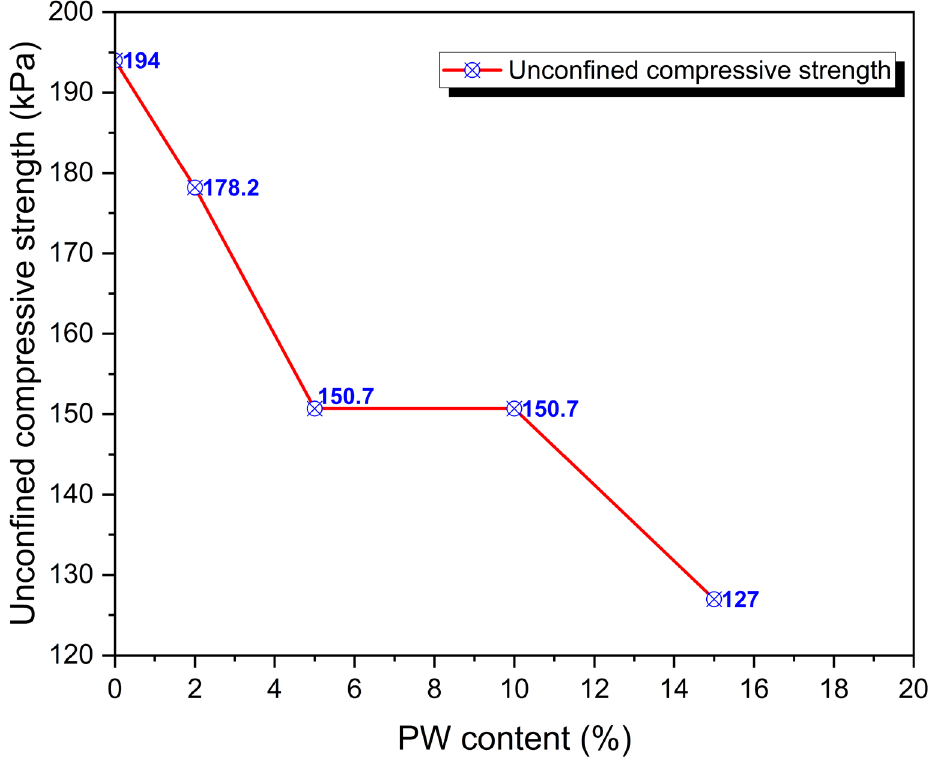
Figure 7. Variation of UCS of cement-stabilised soil with PW content .